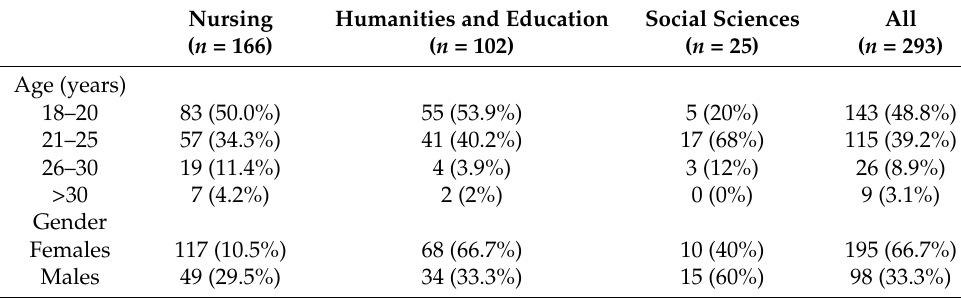
Table 1. Sociodemographic characteristics of participants.